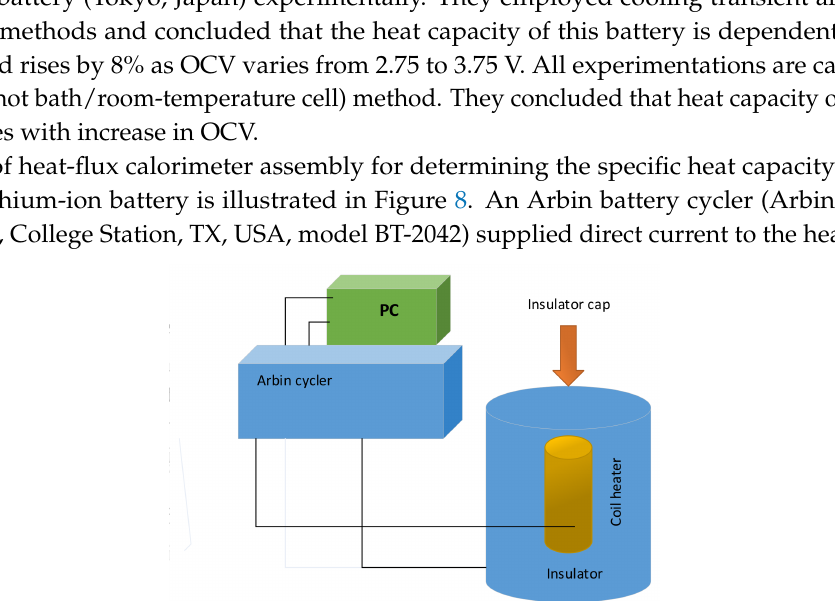
Figure 8. The heating setup which was employed to measure specific heat capacity (method one—cooling transient)